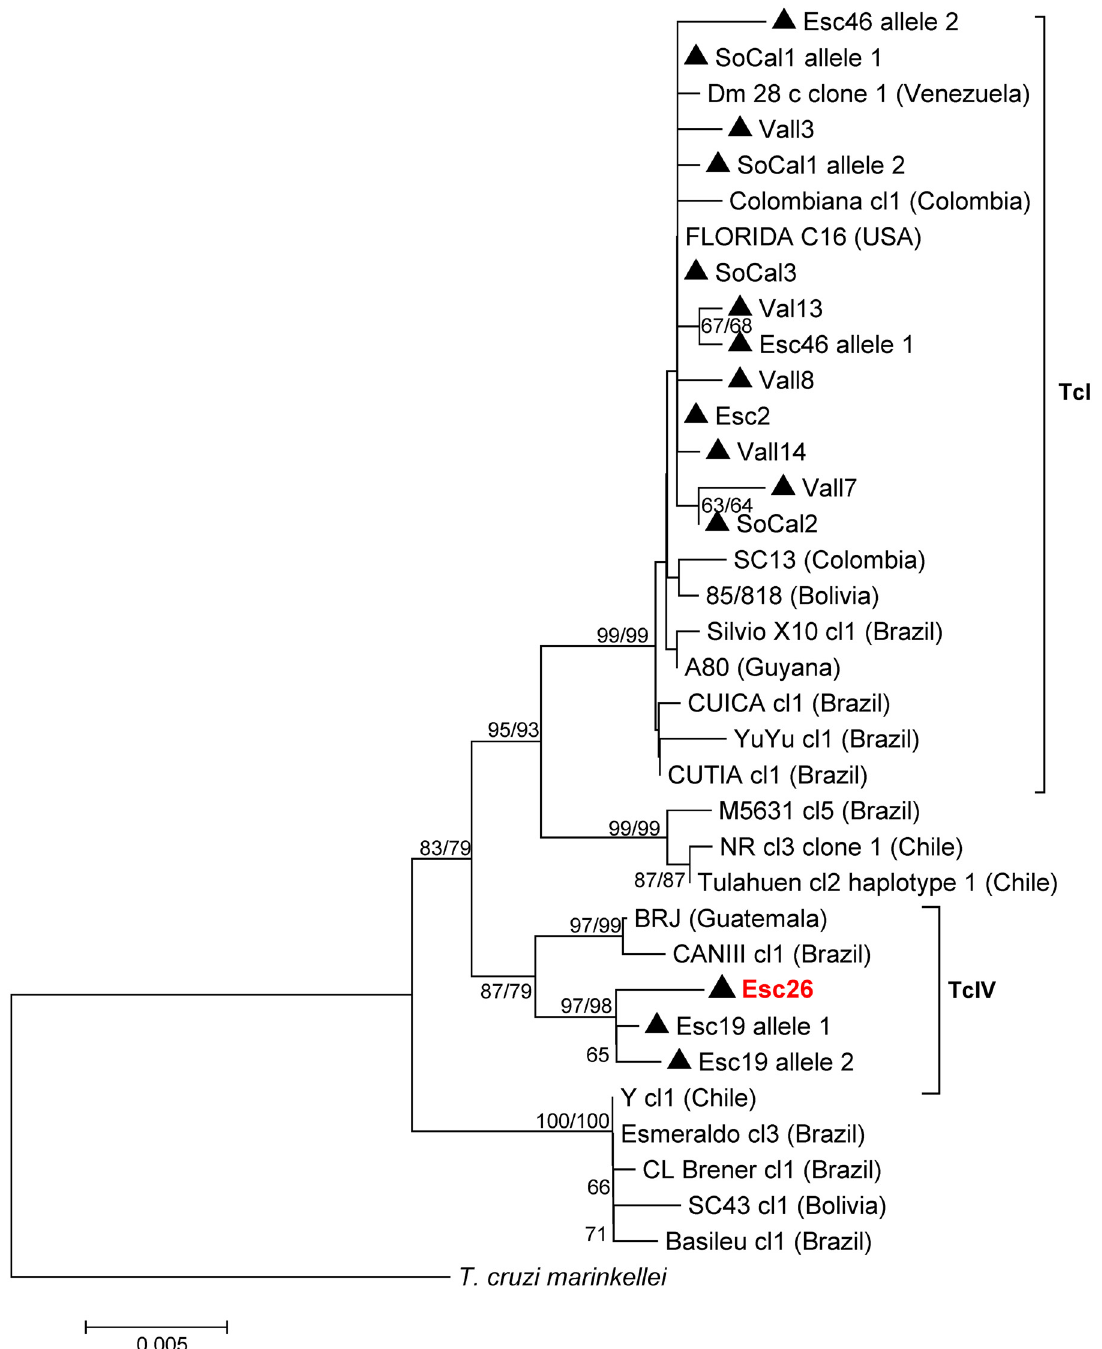
Fig 3. Phylogeny for 35 Trypanosoma cruzi 1288 bp trypanothione reductase sequences. Depicted is the Neighbor-Joining (NJ) tree constructed in MEGA6 with evolutionary distances computed via the Maximum Composite Likelihood method and the scale bar indicating the number of nucleotide substitutions per site. The numbers above or below the nodes represent the bootstrap confidence levels for 2,000 NJ replicates (1 st value) and 500 Maximum Likelihood replicates (2 nd value presented at nodes with congruent topologies) run under the Kimura 2-parameter model for those values (cid:1) 50%. Sequences obtained in this study are indicated by the triangles (Esc = Escondido, SoCal = Southern California, Vall = Vallecito). All other isolates represent published GenBank sequences as listed in S1 Table with their country of origin indicated in parentheses. Tree is outgroup rooted with T . cruzi marinkellei (GenBank